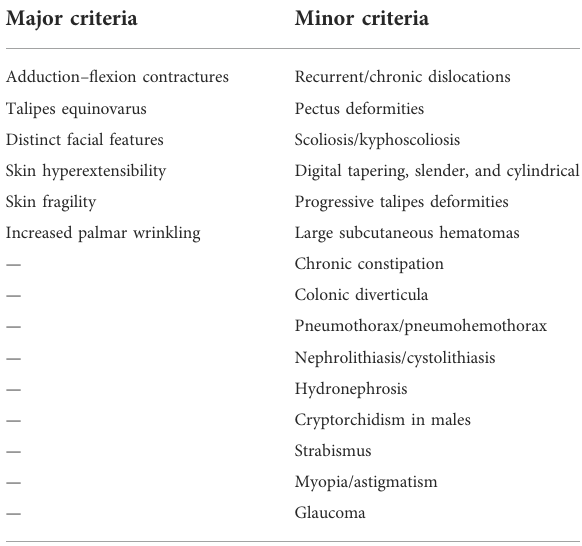
TABLE 2 Diagnostic criteria of